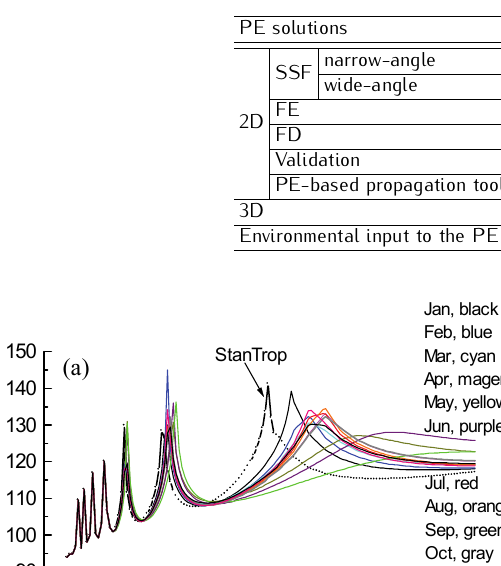
Table 2. Summary of the solutions and environmental input to the PE.